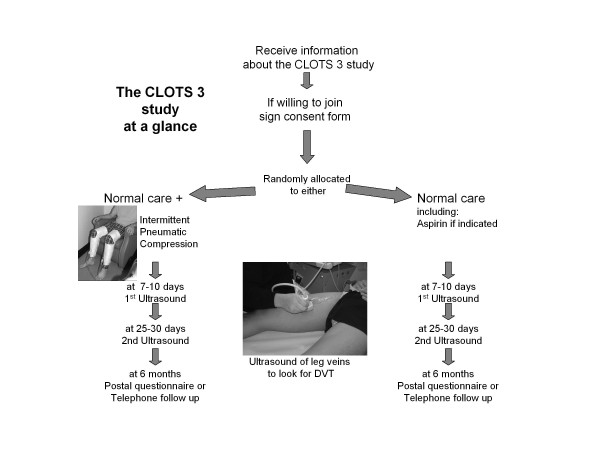
Simplified trial flowchart.